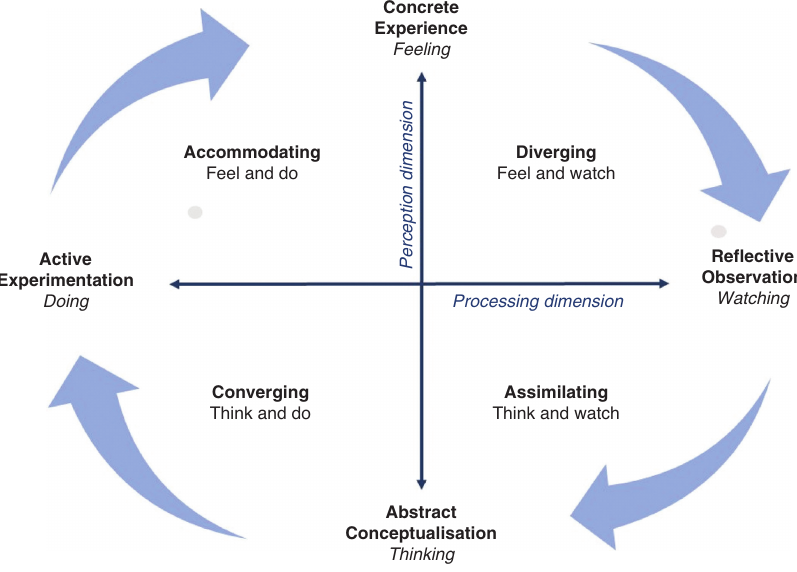
Fig. 1: Kolb’s learning model. Adapted from McLeod (2015).